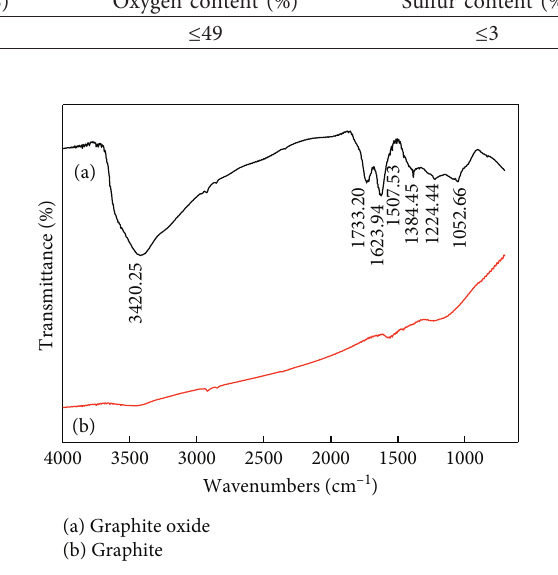
Figure 1: FTIR spectra of GO and graphite.